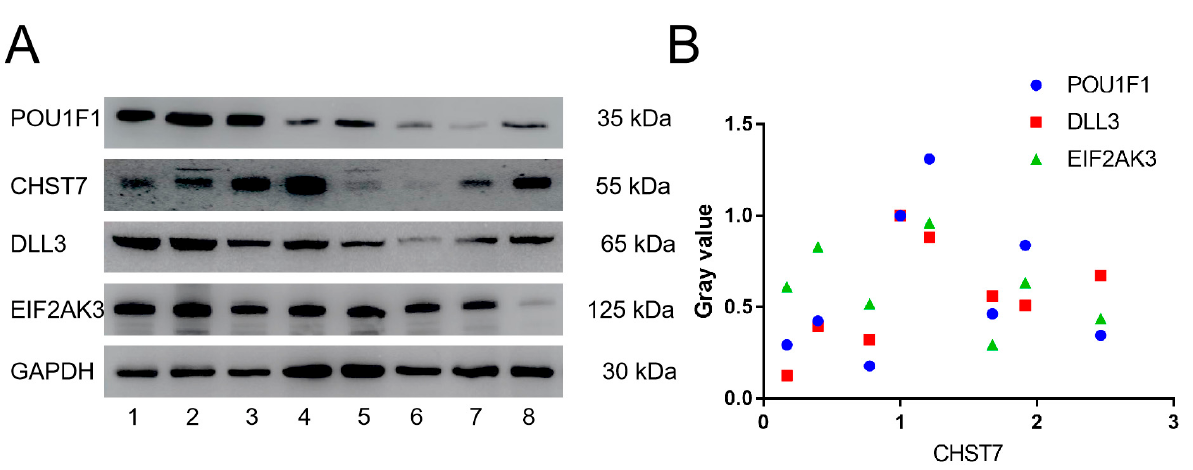
Figure 3. Western blot experiments of CHST7, POU1F1, DLL3, and EIF2AK3. ( A ) Electrophoretic band of CHST7, POU1F1, DLL3, and EIF2AK3 in 8 patients. ( B ) Correlation analysis of CHST7 and POU1F1, DLL3, and EIF2AK3. In this study, the gray value of patient 1 as 1.